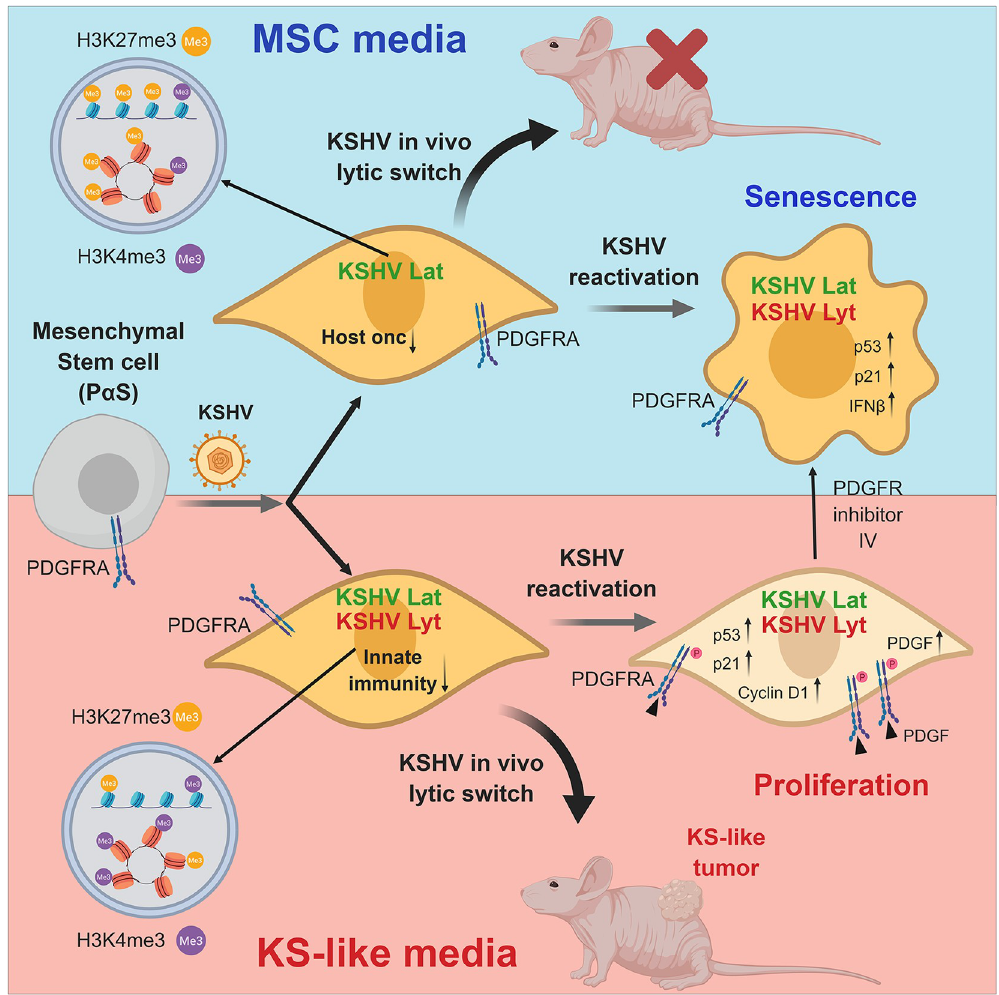
Fig 8. PDGFRA defines the mesenchymal stem cell Kaposi’s sarcoma progenitors by enabling KSHV oncogenesis in an angiogenic environment. Model showing PDGFRA(+)/SCA-1(+) bone marrow-derived mesenchymal stem cells (P α (+)S MSCs) as KS spindle-cell progenitors. Pro-angiogenic environmental conditions typical of KS (KS-like media), inflammation and wound healing are critical for KSHV sarcomagenesis. This is because growth in KS-like conditions generates a de- repressed KSHV epigenome allowing oncogenic KSHV gene expression in infected P α (+)S MSCs. Furthermore, these growth conditions allow KSHV-infected P α (+)S MSCs to overcome KSHV-driven oncogene-induced senescence and cell cycle arrest via a PDGFRA-signaling mechanism; thus identifying PDGFRA not only as a phenotypic determinant for KS- progenitors but also as a critical enabler for viral oncogenesis.